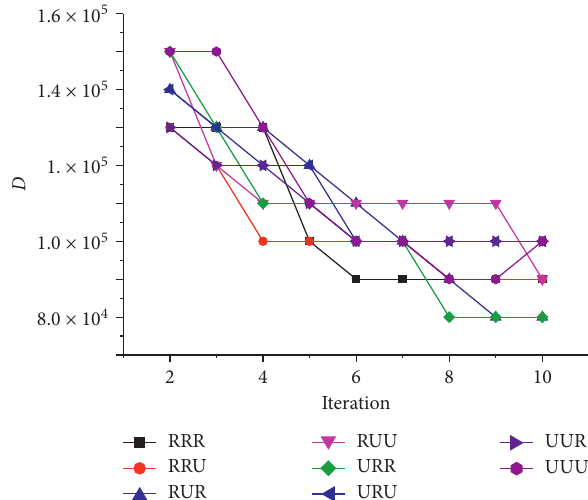
Figure 12: The change trends of traffic flow of different simulation